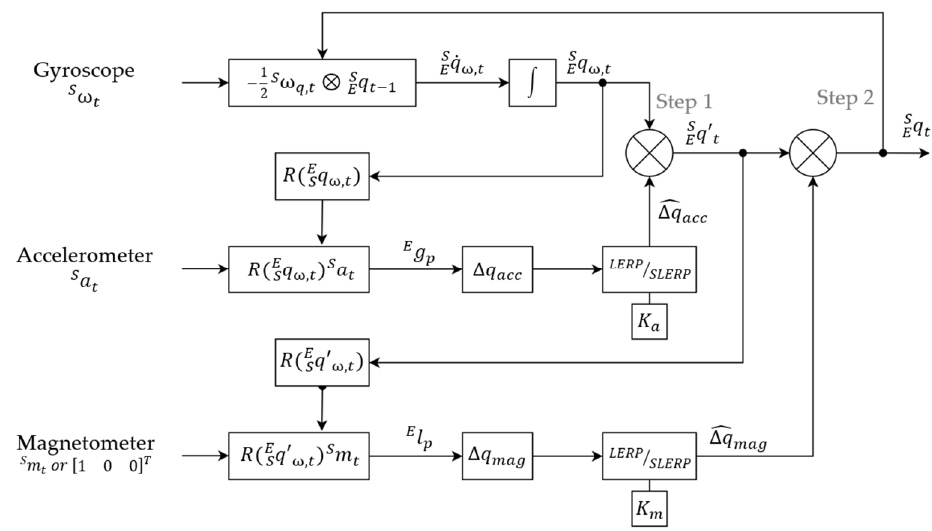
Figure 2. Block diagram of the implemented quaternion-based two-step sensor fusion algorithm, based on the work of Valenti et al. [11]. A canonical vector replaces the magnetometer for the IMU alone. K a = 0.2 and K m = 0.1; ω : measurement from the gyroscope; a : measurement from the accelerometer; m : measurement from the magnetometer; ˆ ∆ q : orientation estimated from acc q : the the accelerometer; ˆ ∆ q : the correction quaternion, calculated from the magnetometer; S mag E orientation of the sensor frame, relative to the earth frame; ⊗ : quaternion multiplication